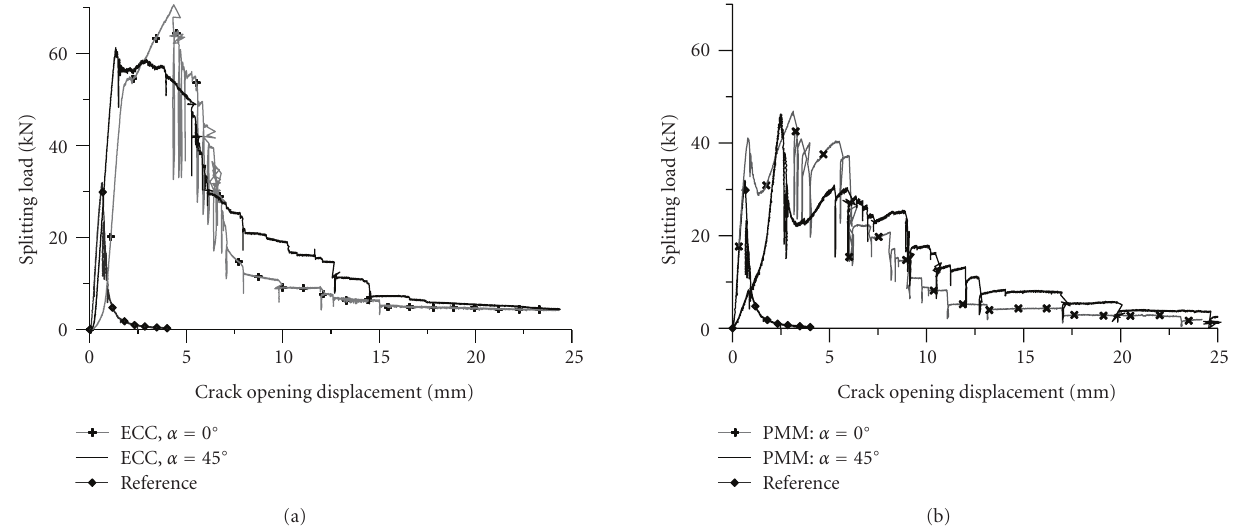
Figure 7: Splitting force versus COD curves for specimens with highest peak load per series, against reference specimen (plain